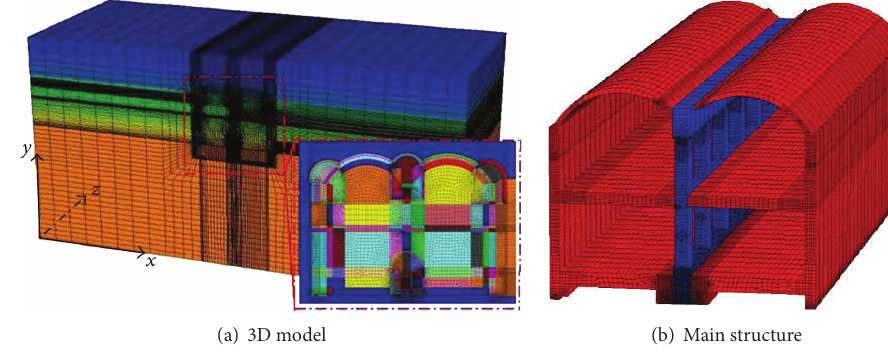
Figure 6: Finite element model.